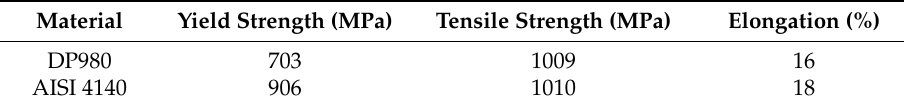
Table 3. Mechanical properties of DP980 and AISI